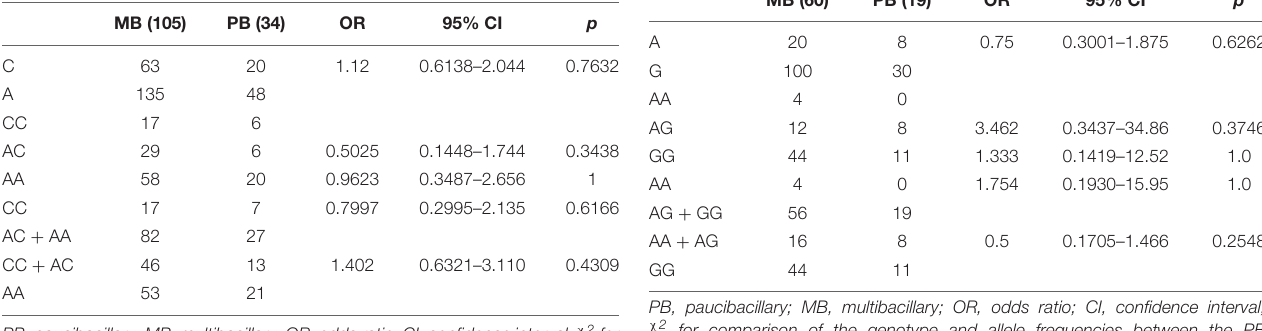
TABLE 3 | Allele and genotype distribution of polymorphisms rs3751143 in the P2RX7 gene between multibacillary and paucibacillary leprosy.